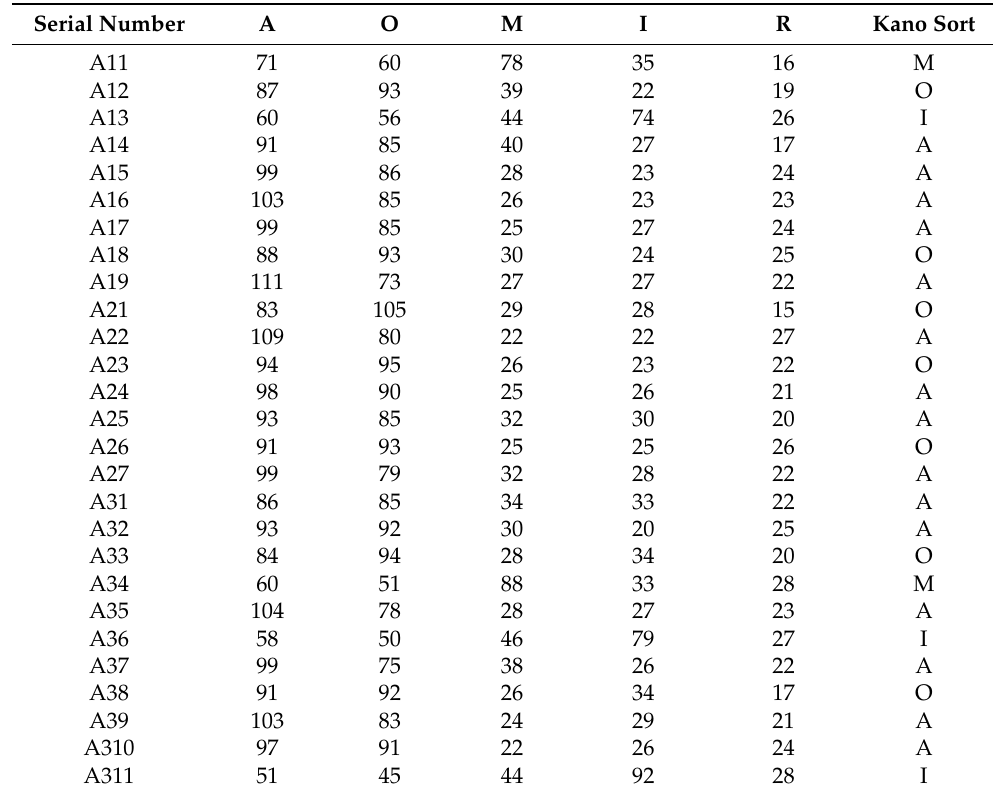
Table 3. Kano model classification table of wood desks.